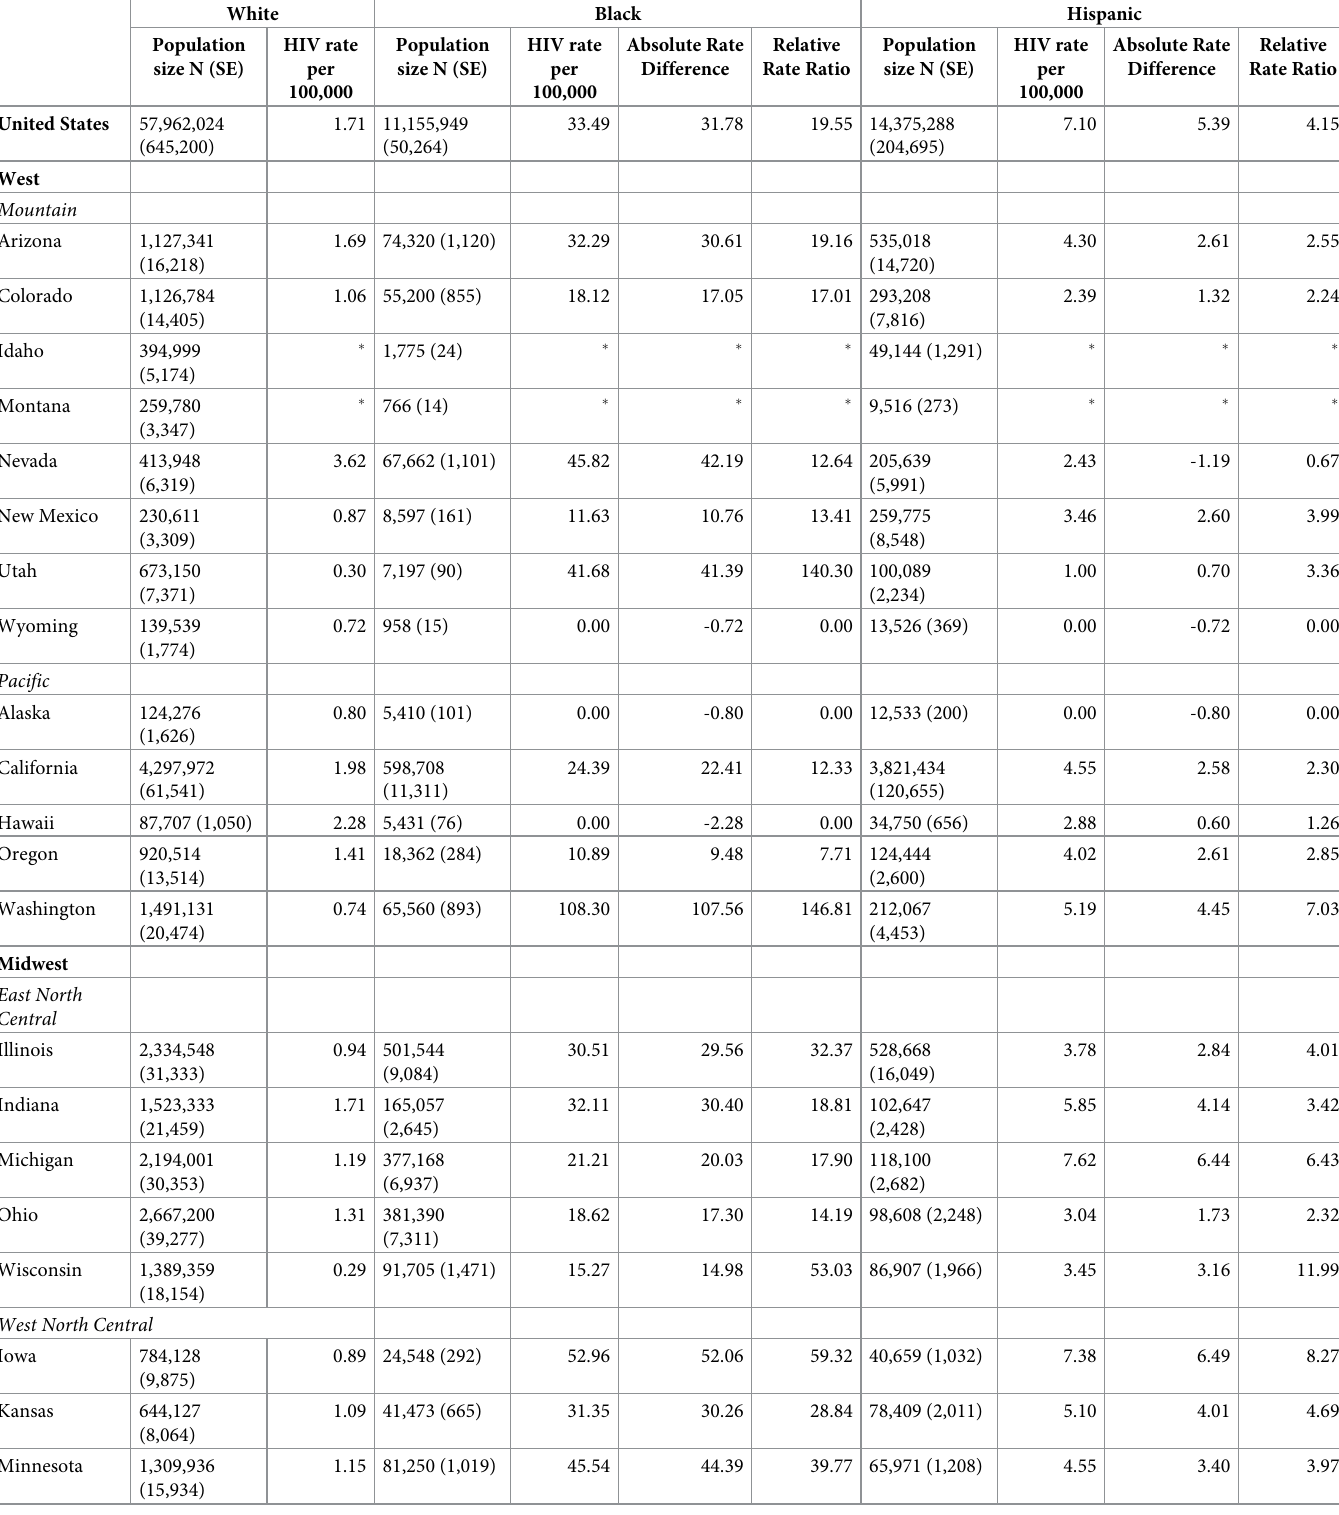
Table 2. State-level estimates of heterosexually active Women Ages 18+, HIV diagnosis rates, and disparity measures.